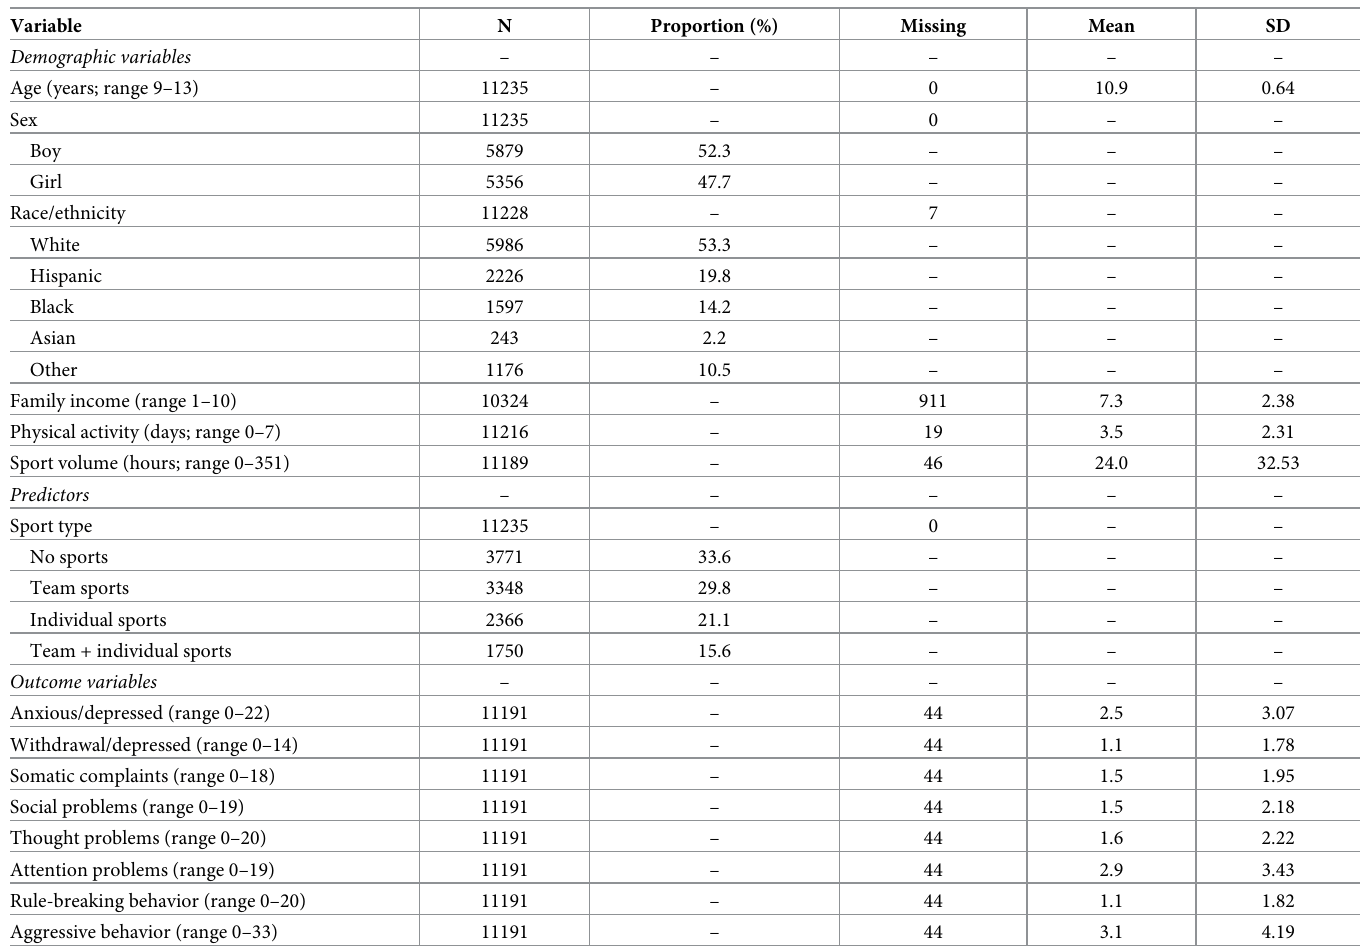
Table 1. Descriptive statistics of study